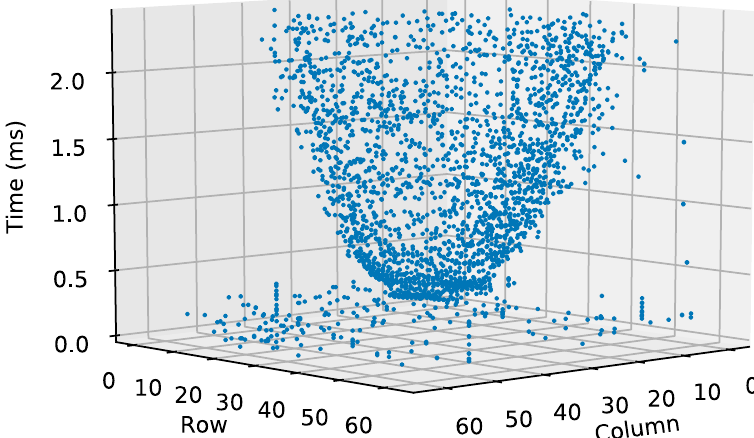
Figure 13. Three-dimensional representation of pixel co-ordinates (row and column) over time. Pixel- reading period was 560 ns. Event occurred after Pixel 500 (0.280 ms).